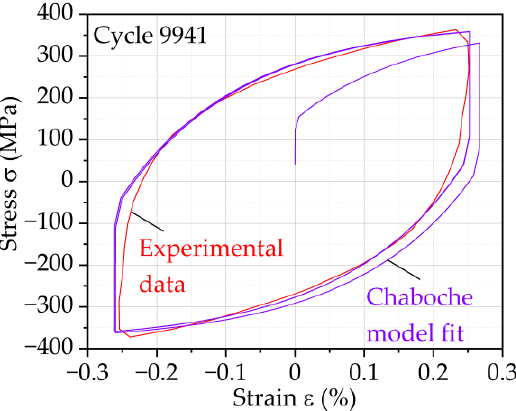
Table 3. Chaboche parameters for 240 °C, determined at load cycle 8000. Figure 9. Results of a simulation of a hysteresis loop using the Chaboche parameters compared to measured data for RT (Specimen NA01).